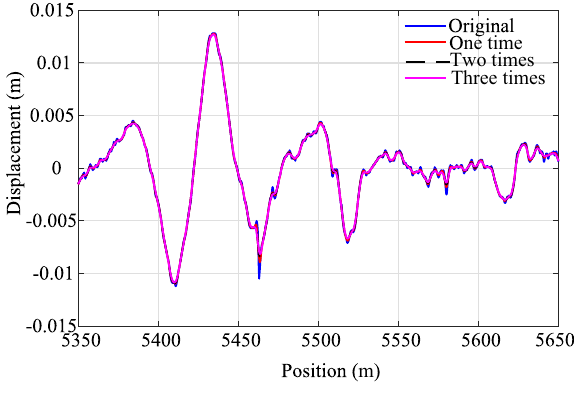
Fig. 6 The track displacement observations after using the kernel multiple times. Only the lateral displacement of the left rail is